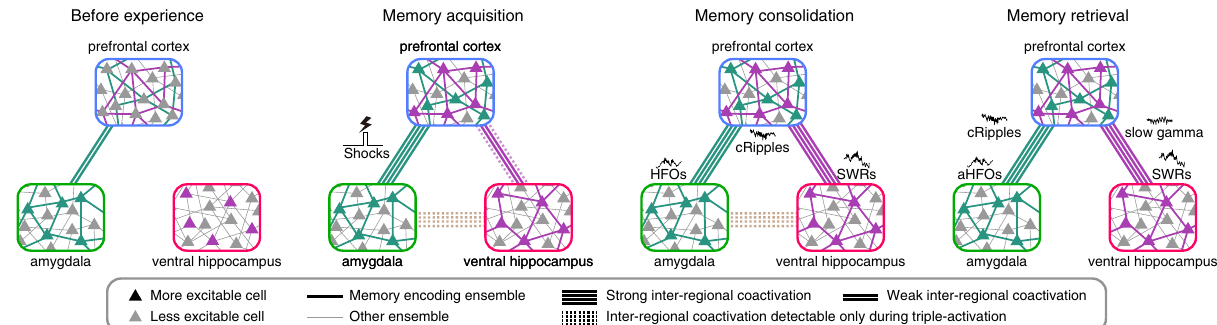
Fig. 10 Coactivations of precon fi gured local ensembles support memory. Schematic summary of inter-regional ensemble-coactivation development suggests that elements of memories are instantly embedded in precon fi gured amygdalar and prefrontal cortical ensembles, whereas the inter-regional network that binds the distributed information develops in an experience-dependent manner (left two panels). The coactivation between hippocampal and prefrontal cortical ensembles is enhanced through an initial stage of memory consolidation, which occurs during the subsequent sleep period (second right panel). During memory retrieval, the prefrontal cortical ensembles are coactivated with amygdalar/hippocampal ensembles (rightmost panel). Inter- regional ensemble coactivations during post-learning sleep and memory retrieval are associated with fast network oscillations (right